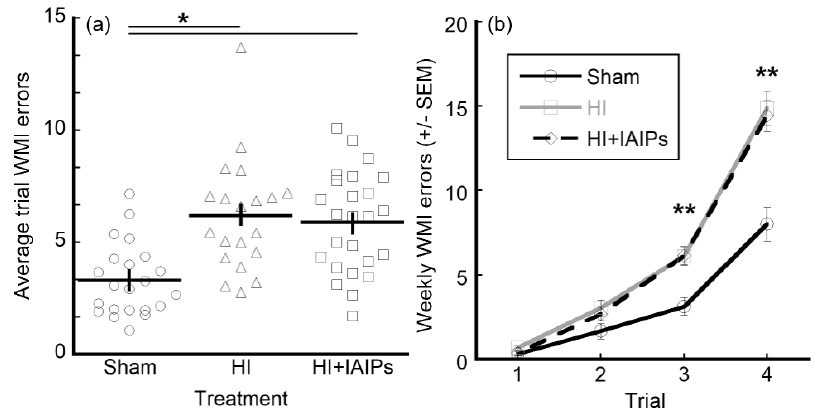
Figure 3. Treatment effects on WMI errors (±SEM), a moderate cognitive demand task component. Total n = 67, Sham (22), HI (20), HI + IAIPs (25). Horizontal bars indicate mean and vertical error bars represent SEM. ANOVA and post-hoc tests indicate both HI and HI + IAIPs treatment groups performed worse than Shams in overall WMI errors across all trials and weeks ( a ) * indicate significant differences by Tukey’s homologous subsets and ( b ) ** indicates both HI and HI + IAIPs performed significantly worse than Sham in later trials of the maze protocol over all weeks by paired comparison with Sidak correction.